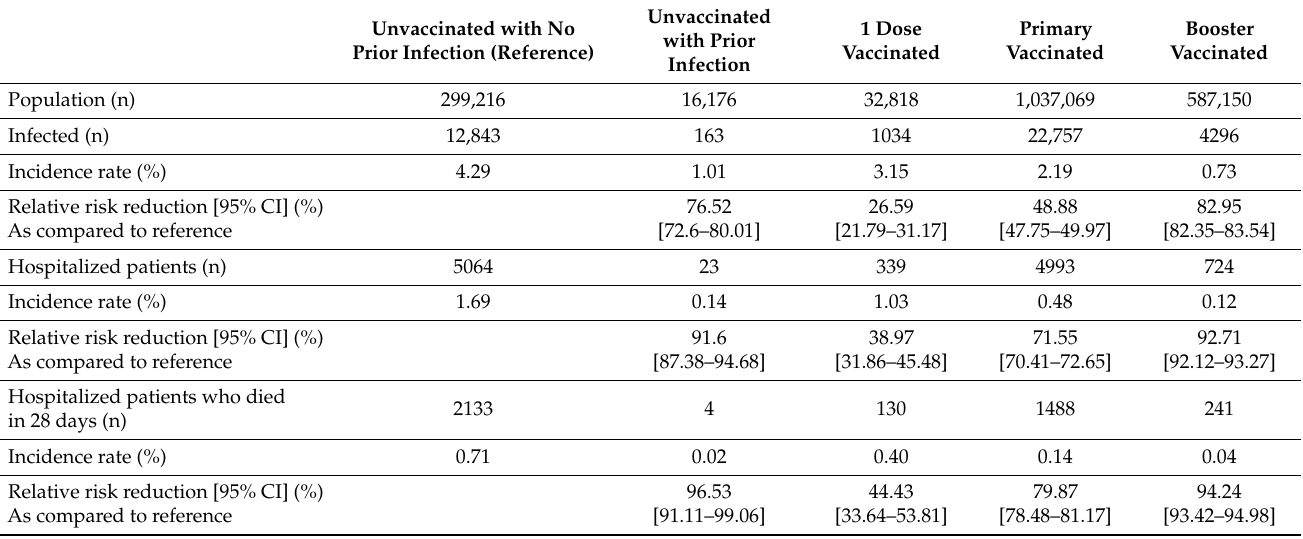
Table 2. SARS-CoV-2 delta VOC infection, hospitalization, and mortality in the studied populations. Unvaccinated with No Prior Infection (Reference)